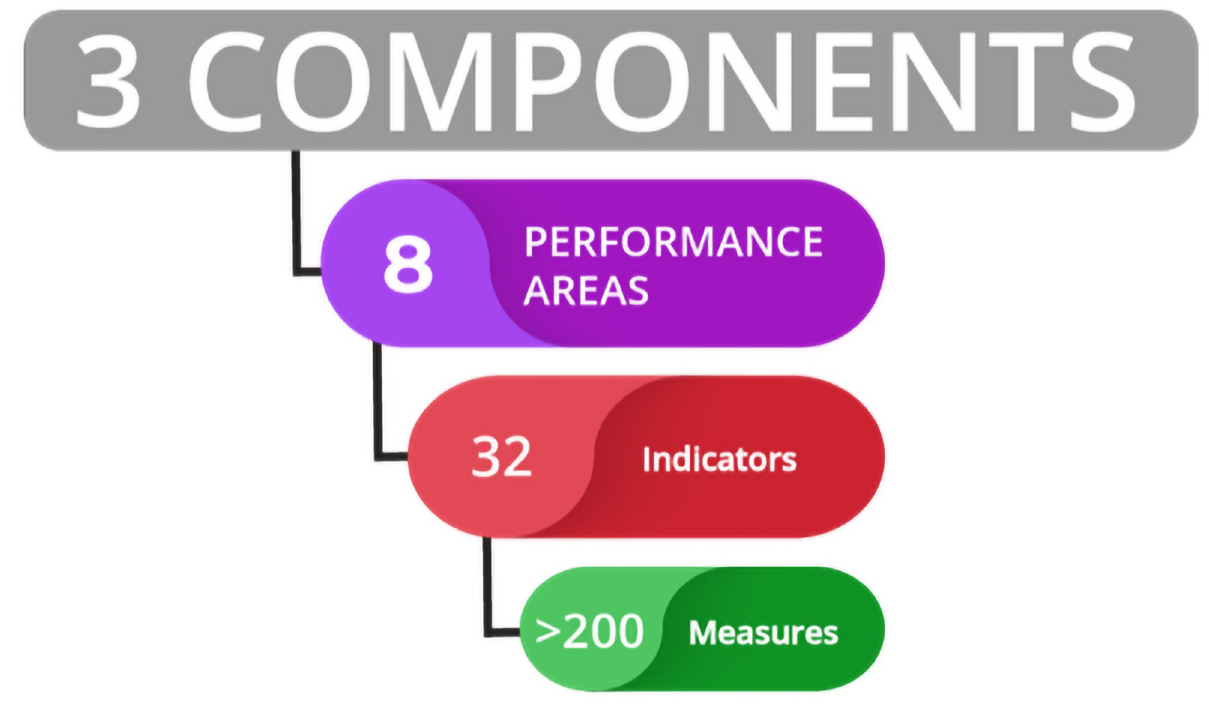
Fig 1. The hierarchal structure of the fisheries governance tool begins with high-level components, that comprise eight performance areas, under which 32 indicators and over 200 measures collectively capture a comprehensive picture of policy, capacity, and performance outcomes.